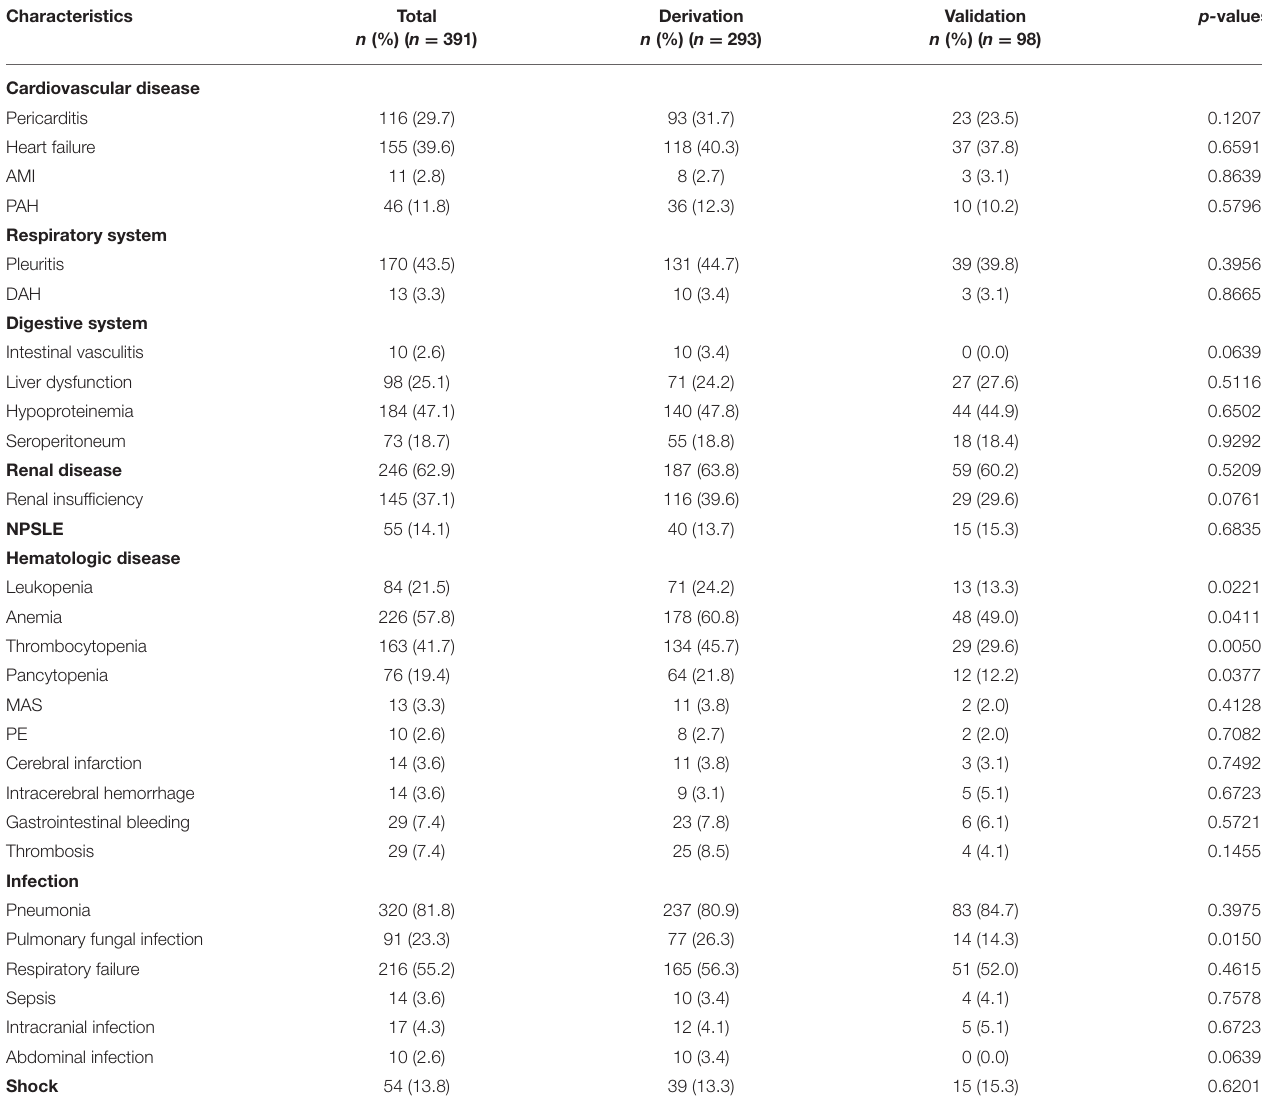
TABLE 3 | Clinical feature during ICU of the 391 patients. Characteristics